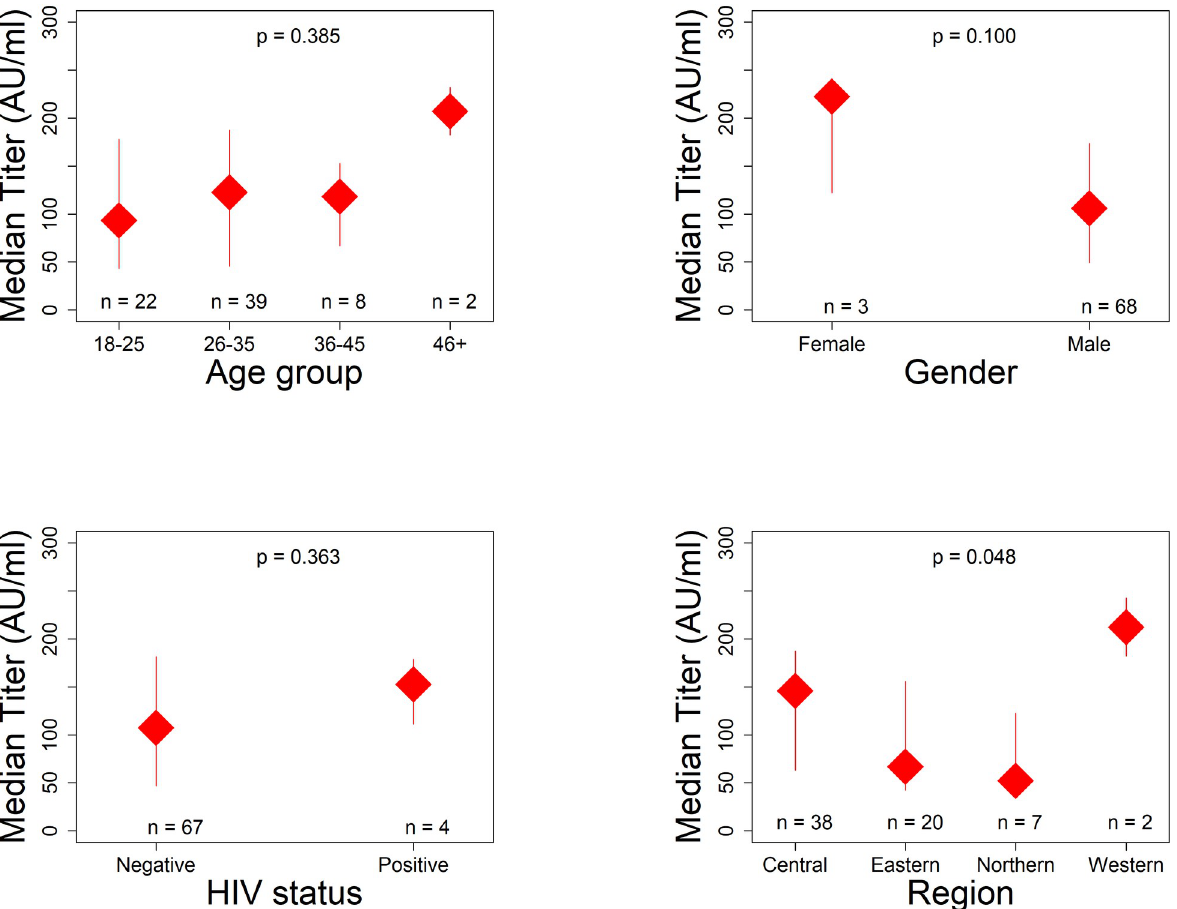
Fig 2. Antibody titers (AU/mL) classified by age group, gender and region of residence of donors. It is noted in Fig 2 that age greater than 46 years and female gender were associated with higher titers though this was not statistically significant.